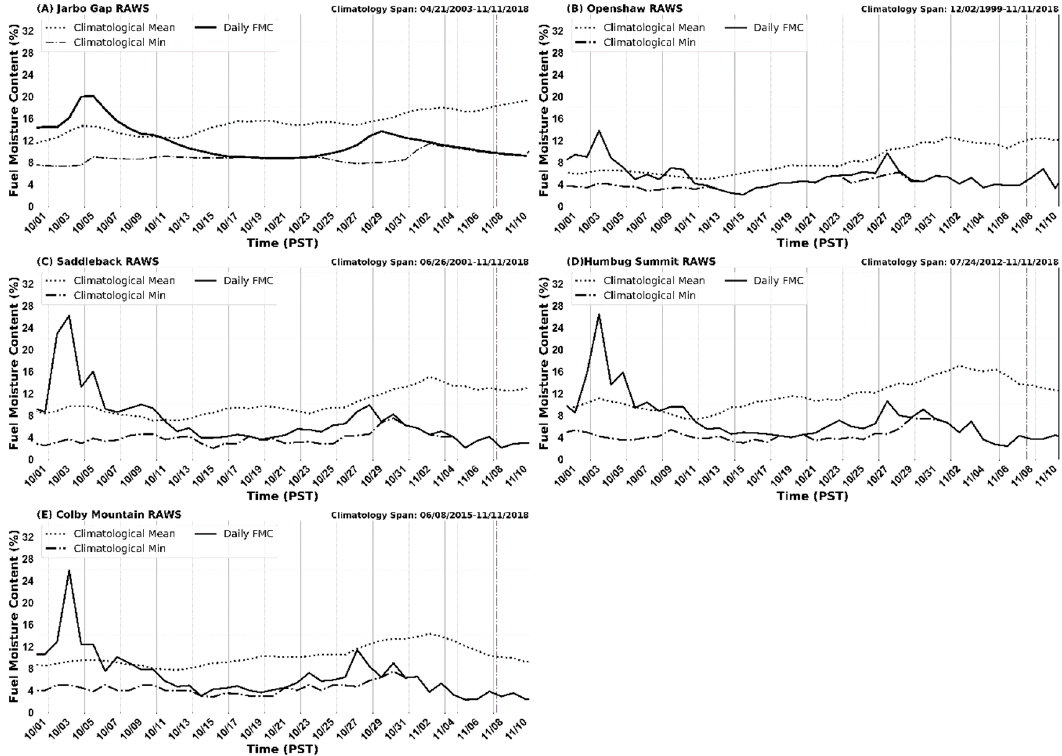
Figure 3. Calculated FM-100 for RAWS in the area surrounding the Camp Fire. Solid line indicates fuel moisture content (FMC) at the date shown in 2018, dashed line indicates recorded minimum FMC, dotted is daily average for recorded period. Vertical dashed line indicates approximate ignition time. Table 1 gives the climatological record for each station.